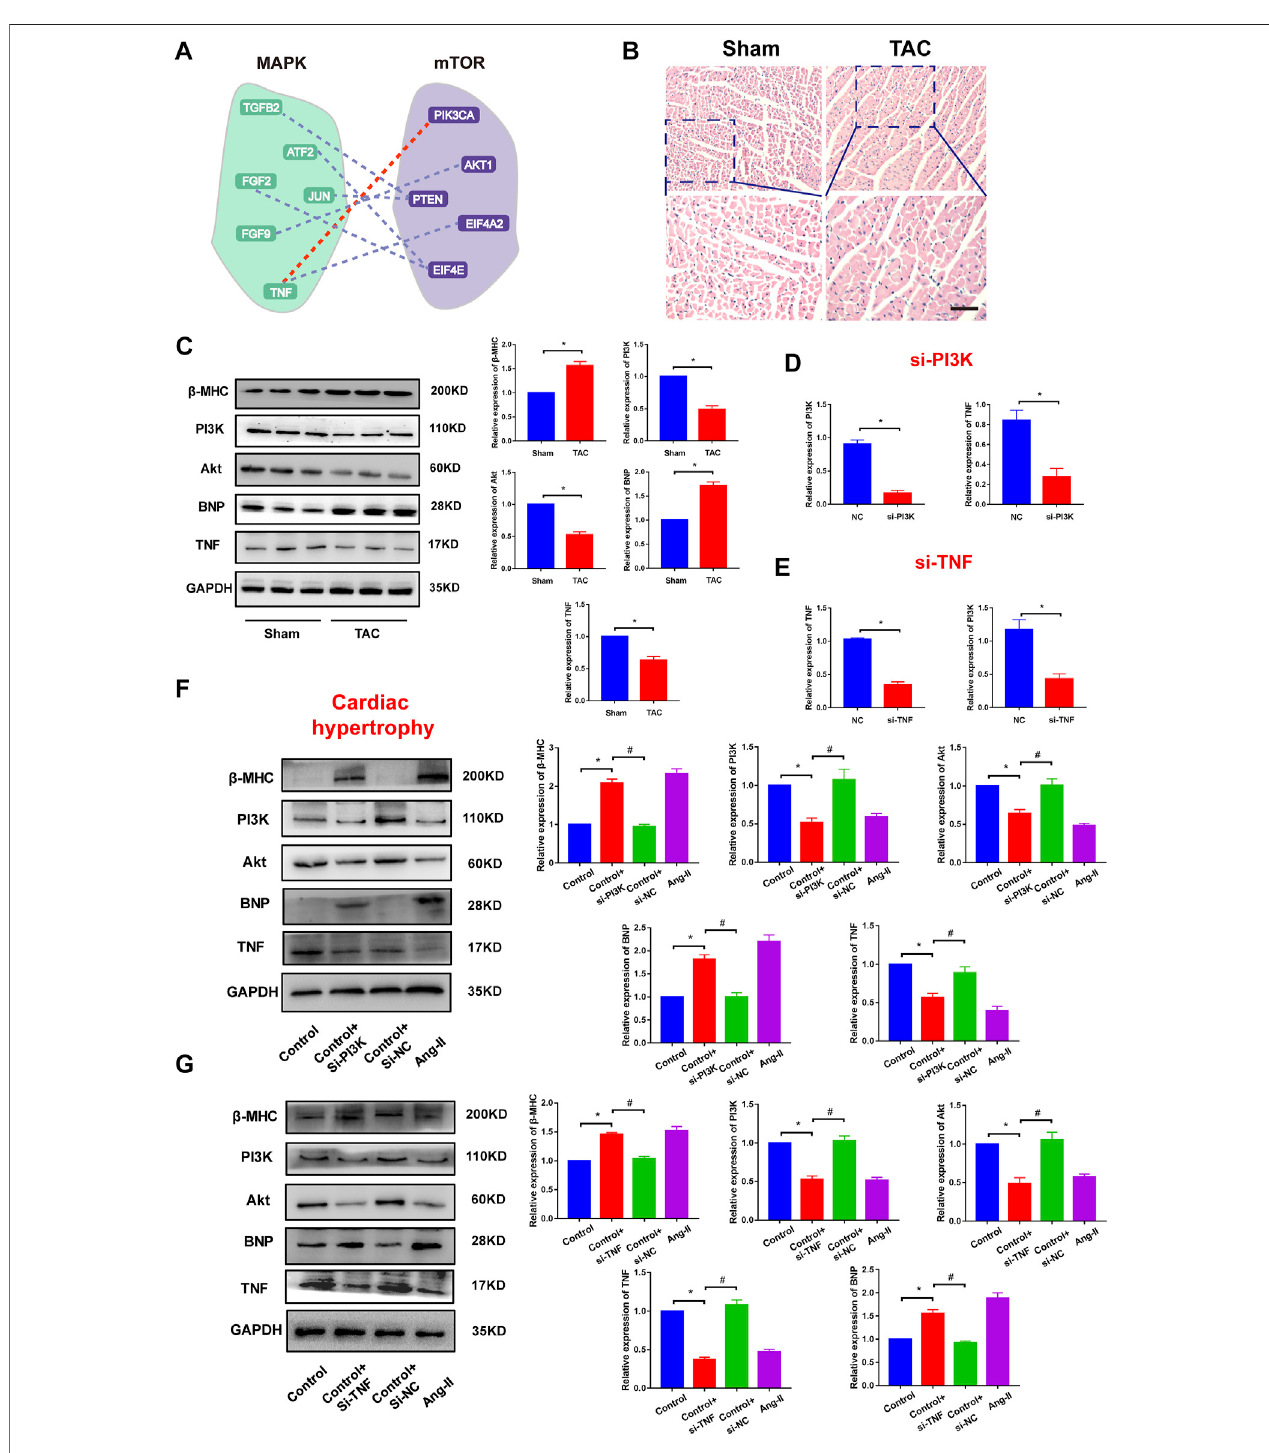
FIGURE 4 | Validation of pathway crosstalk in cardiac hypertrophy. (A) A pathway – pathway crosstalk of common core pathway crosstalk network. Red line representstheceRNAcrosstalkthatwasperformedinthisstudy. (B) HEstainingresultsofcardiac tissues.Bar:100 μ m. (C) Proteinexpressionofhypertrophymarkers, PI3K,Akt,andTNFinShamgroupsandTACgroupsandcorrespondingstatisticresults. n =6. *p < 0.05versusShamgroup. (D) Real-timePCRresultsofPI3KandTNF expression in PI3K knockdown experiments. n = 6. *p < 0.05 versus. NC group. (E) Real-time PCR results of PI3K and TNF expression in TNF knockdown experiments. n = 6. *p < 0.05 versusNC group. (F) Protein expression ofhypertrophy markers, PI3K, Akt, and TNF inPI3K knockdown experiments and corresponding statistic results. *p < 0.05 versus control group, #p < 0.05 versus. Control + si-PI3K group. n = 6. (G) Protein expression of hypertrophy markers, PI3K, Akt, and TNF in TNF knockdown experiments. *p < 0.05 versus control group, #p < 0.05 versus control + si-TNF group. n = 6.